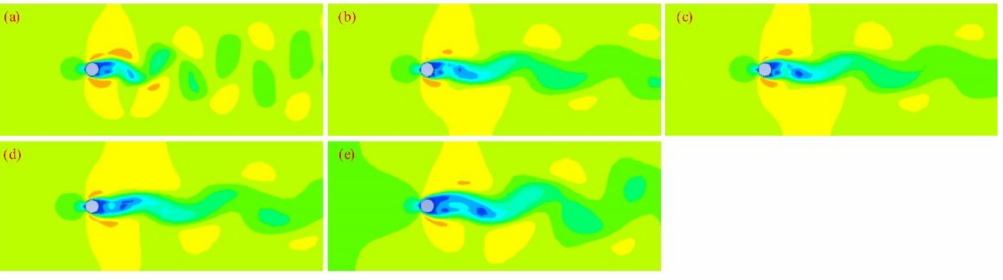
Figure 11. Vorticity simulation of the TS–tower: ( a ) O–tower; ( b ) n = 4; ( c ) n = 12; ( d ) n = 30; and ( e ) n =